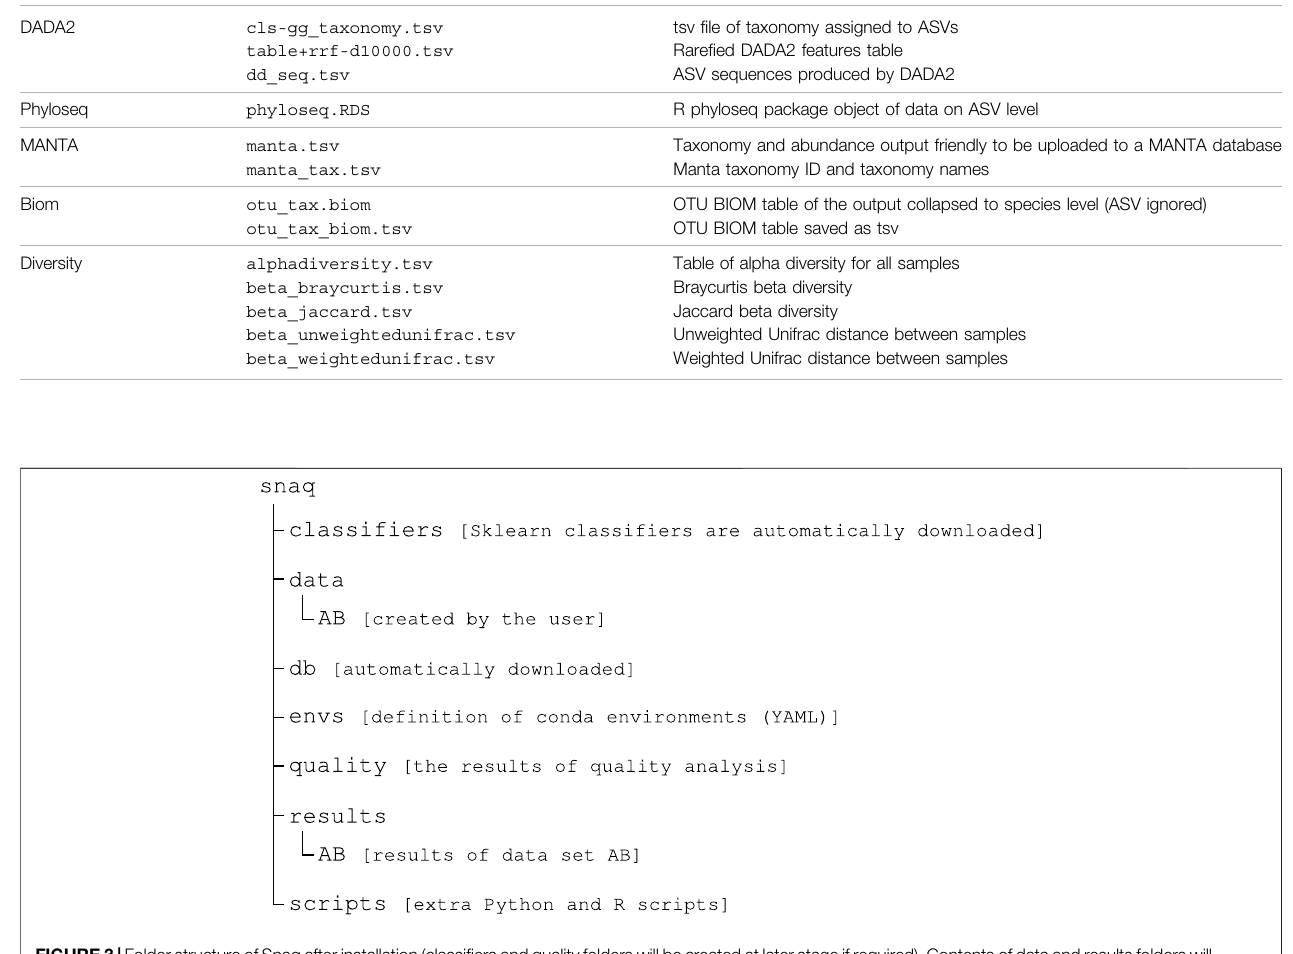
TABLE 2 | Summarized output, all the fi les are preceded by the parameters for the analysis. Group